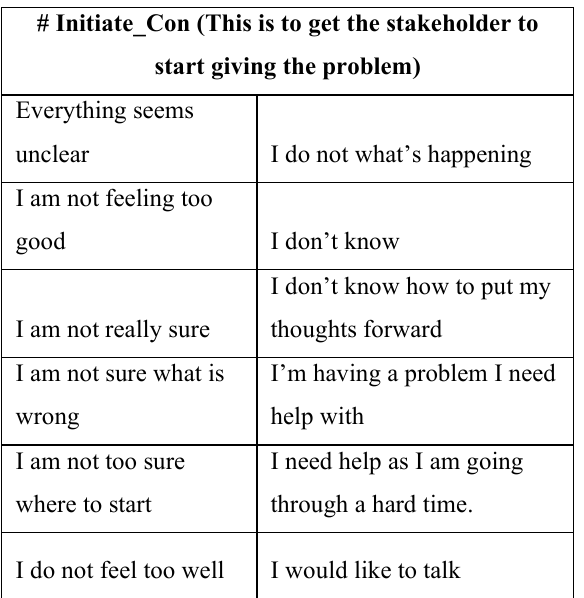
Table 3. Intent #Initiate_Con Details and case examples configured